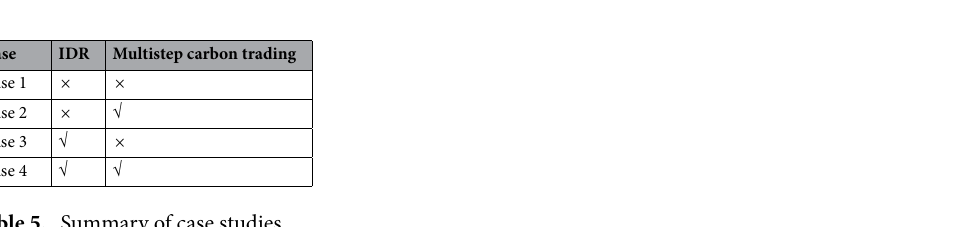
Table 5. Summary of case